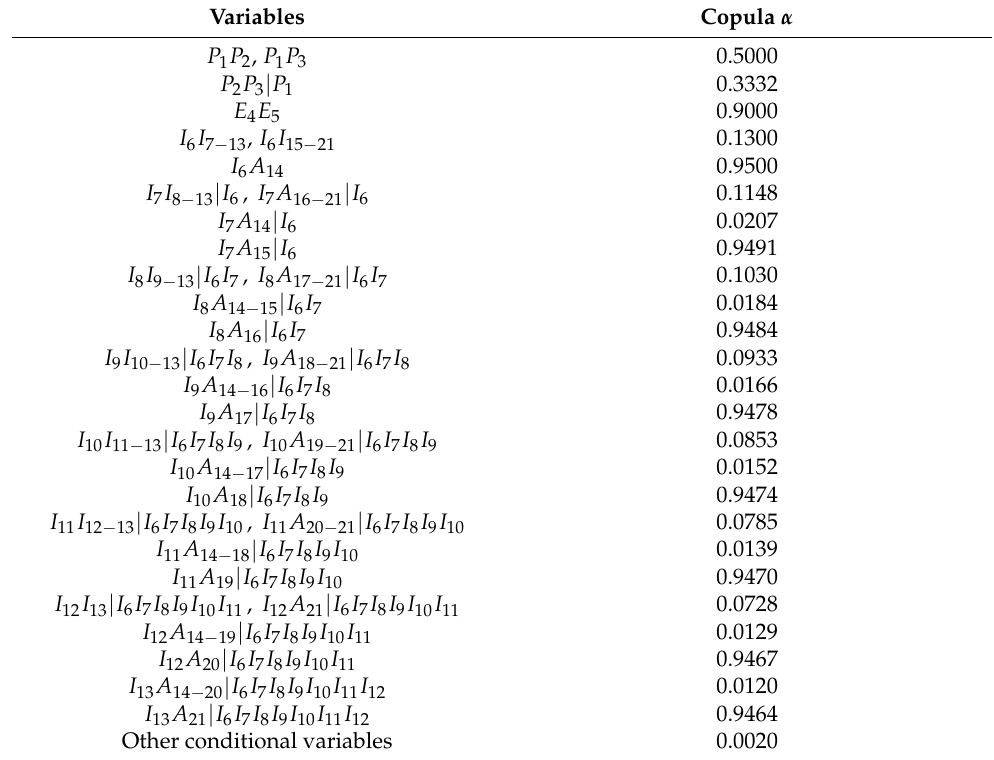
Table A1. Parameters of the Optimal Bivariate Copula Functions, test 5.